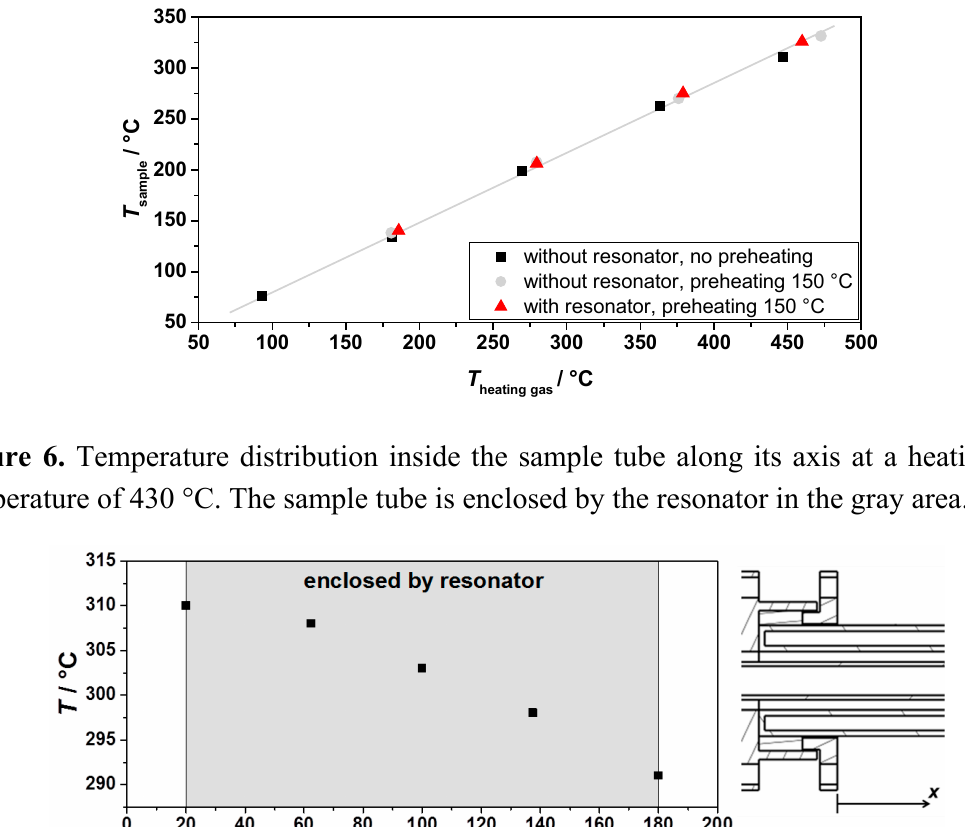
Figure 5. Results of the heating tests with and without resonator and preheating.